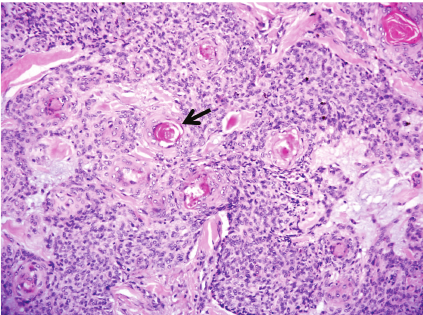
Figure 22: Keratotic BCC: medium-power magnification showing solidgrowthoftumorcellswithfociofsquamousdifferentiationfea- turing keratin pearls (arrow). Focal tumour-stromal cleft formation with myxoid substance is seen on the right. (H&E, ×